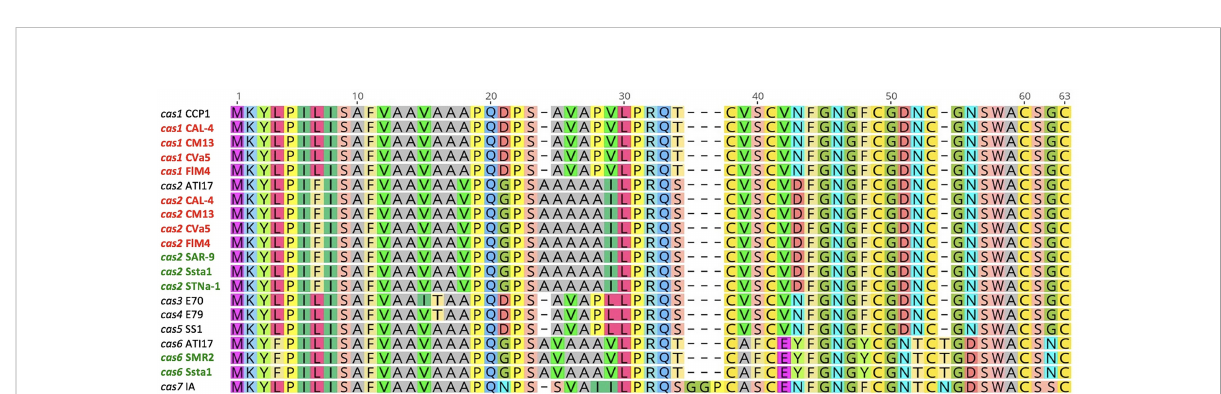
FIGURE 2 Amino acid sequence alignment of the cassiicolin precursor proteins of the 7 known Cas variants in Corynespora cassiicola . Cas designation and isolate name are shown before each corresponding sequence. Isolates that we collected and sequenced for this study are indicated in bold. The sequences with names in red are from cotton isolates and the sequences with names in green are from soybean